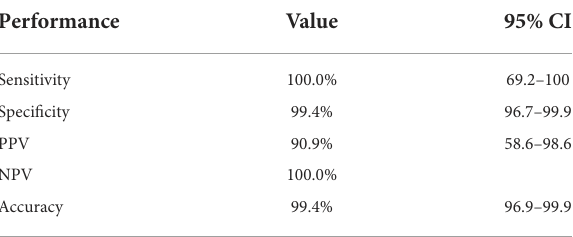
TABLE 4 Diagnostic performance of Xpert MTB/RIF for the detection of rifampicin resistance as compared with gold standard MGIT